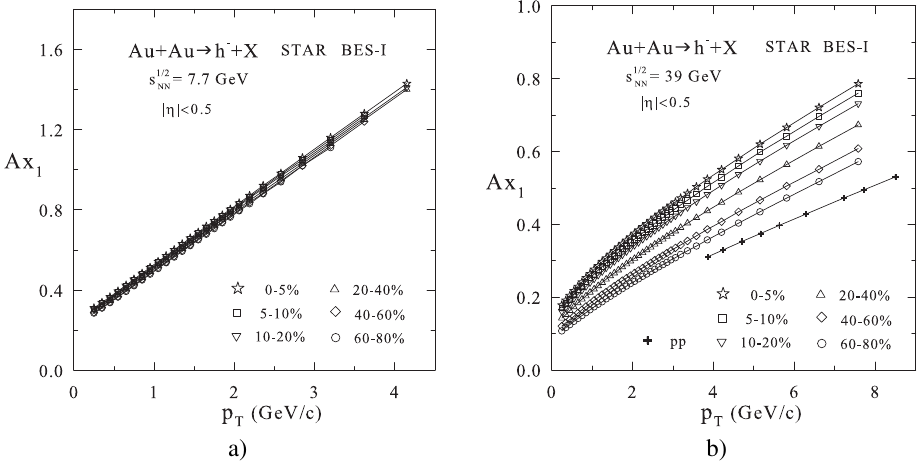
The dependence of the momentum fraction Ax 1 on the transverse momentum p T of h − hadrons produced in Au + Au collisions at the energy centralities and | η | < 0 .